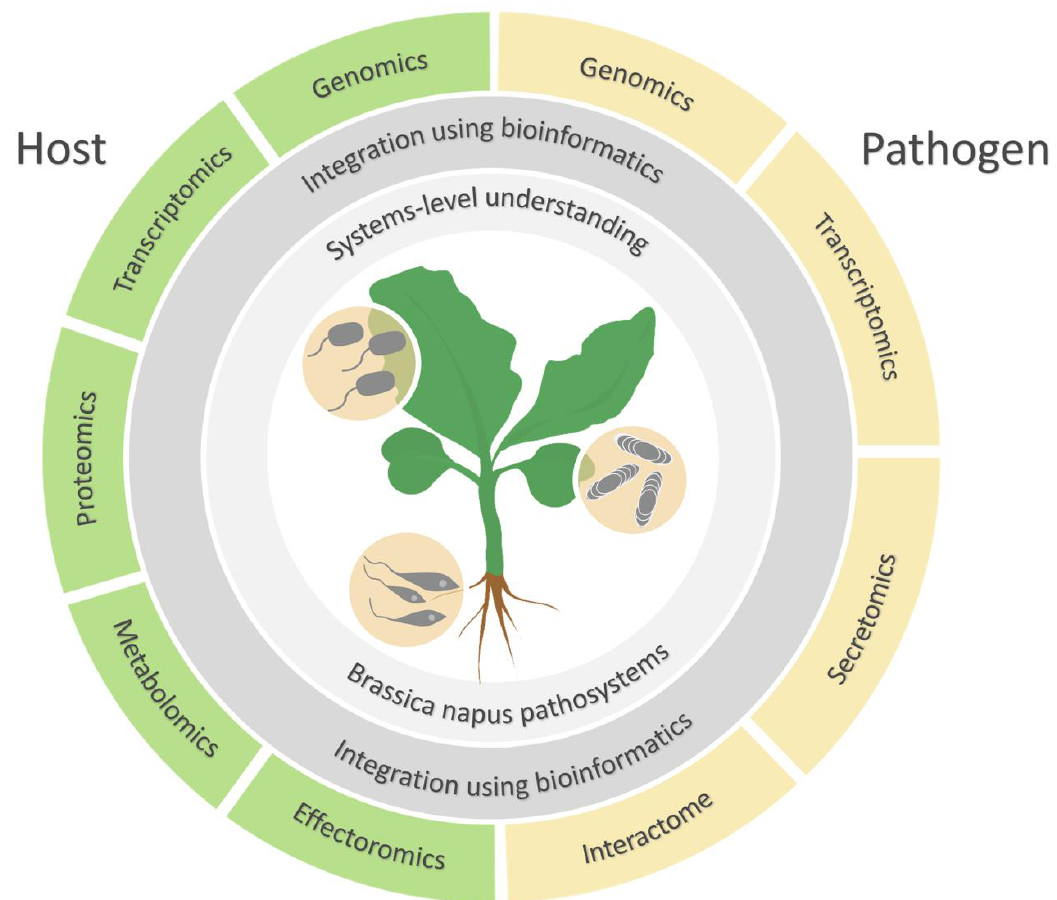
Figure 1. The integration of omics studies in B. napus pathosystems.